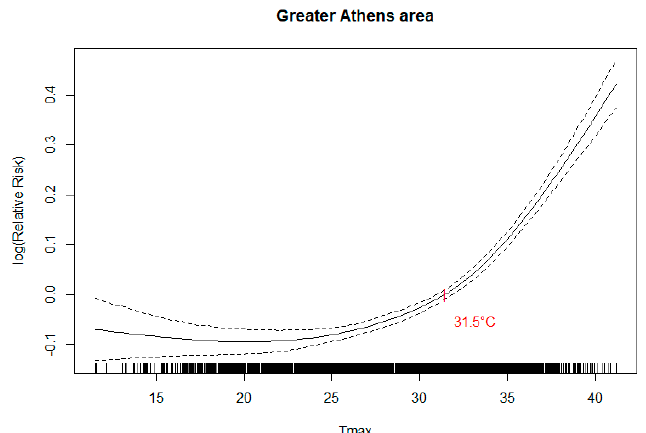
Figure 2. Temperature-mortality association (dotted line: 95 % Confidence Interval) for the Greater Athens Area, using the Thissio measurements.